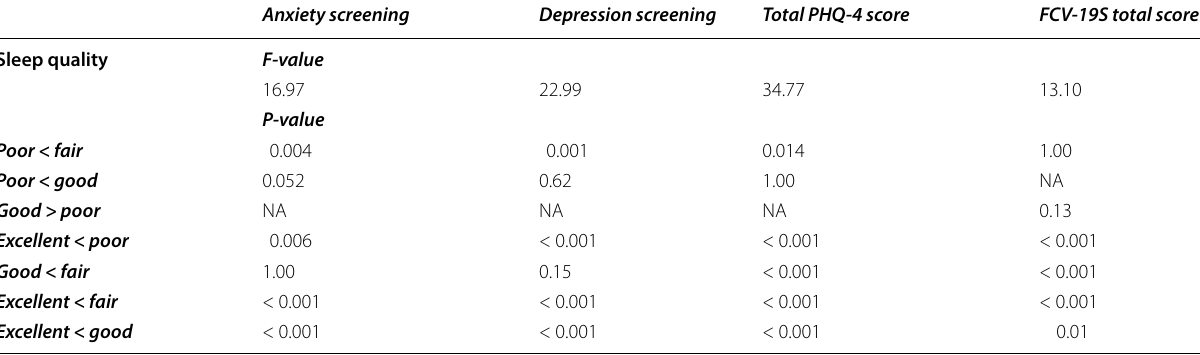
Table 2 Bonferroni adjustment for ANOVA multiple comparisons of sleep quality with anxiety, depression, PHQ‑4 total score, and FCV‑ 19S score ( n =